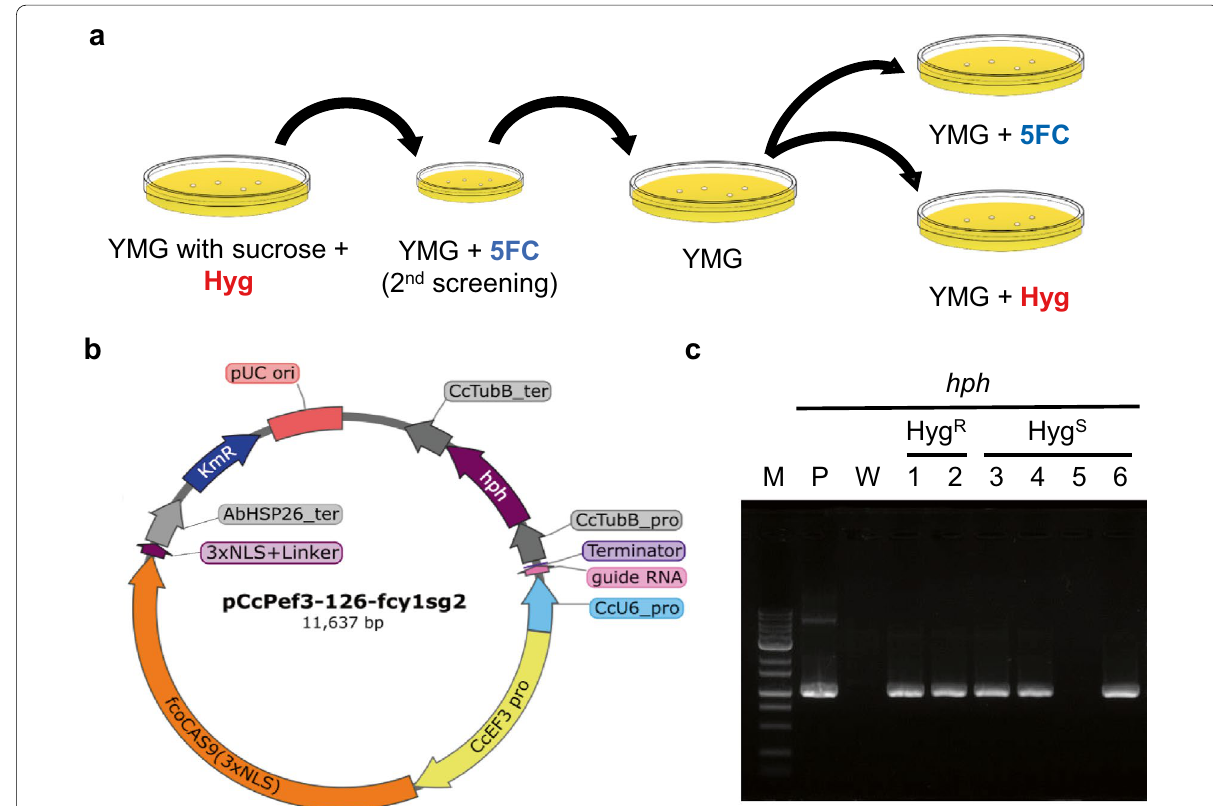
Fig. 2 Marker-free genome editing by transient expression of Cas9, gRNA, and hph . a Schematic diagram of marker-free genome editing. b The plasmid map of pCcPef3-126-fcy1sg2. pUC ori: origin for Escherichia coli , KmR: kanamycin resistance gene, AbHSP26_ter: terminator from hsp26 gene in Agaricus bisporus . NLS: Nuclear localization signal, fcoCas9: Fungal and plant codon optimized Cas9 [10], CcEF3_pro: Promoter from ef3 gene in Coprinopsis cinerea , CcU6_pro: U6 promoter from C. cinerea , CctubB_pro or ter: Promoter or terminator from tubulin gene in C. cinerea , hph : hygromycin phosphotransferase. c PCR amplification of hph fragment using primer set hph_F and hph_R. Lane M, 1-kb ladder (Nippon gene); lane